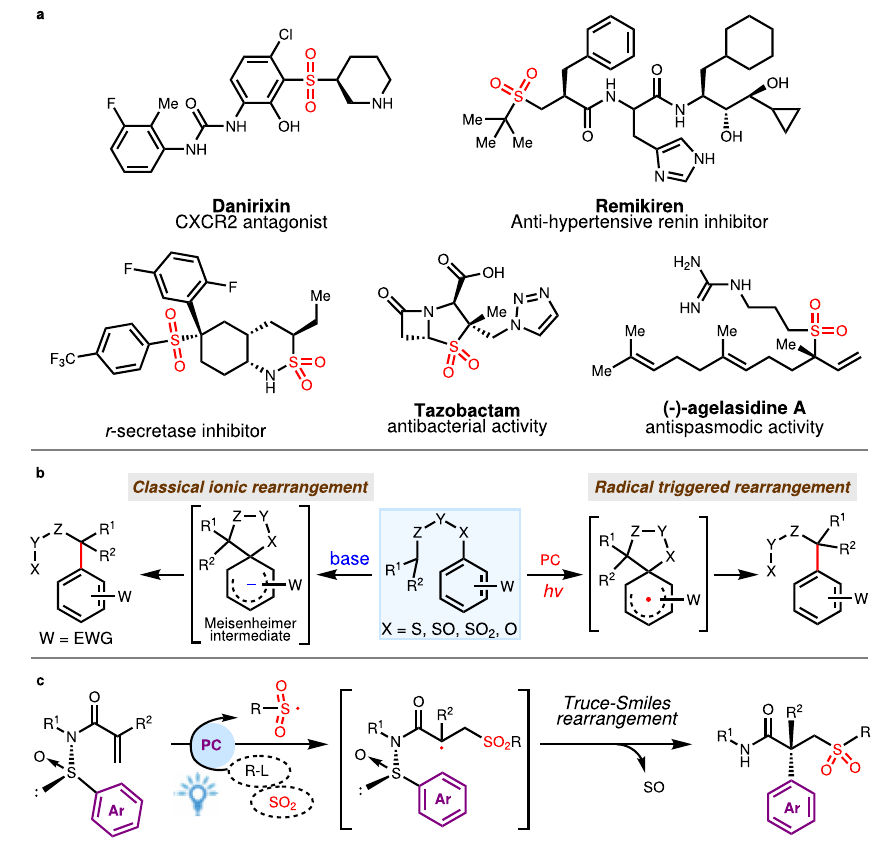
Fig. 1 | Valuable chiral sulfone-containing molecules and their construction. a Representative bioactive molecules containing chiral sulfone motif.